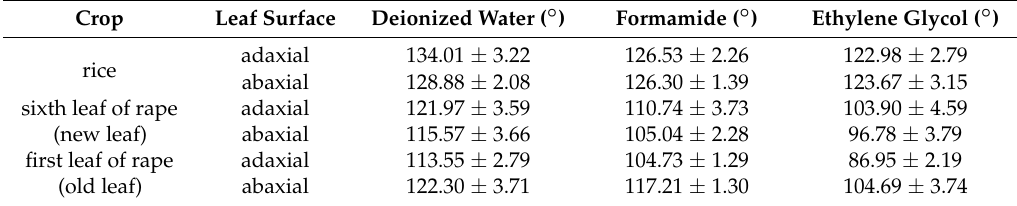
Table 3. Contact angles of probe liquids on rice and rape leaves.